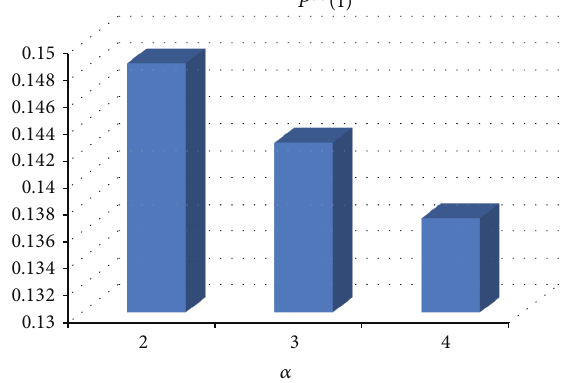
Figure 4: Effect of 𝛾 and 𝜂 on the probability that server is on vacation (𝛼 = 2 , 𝛽 = 6 , 𝜂 = 2,3, 4)